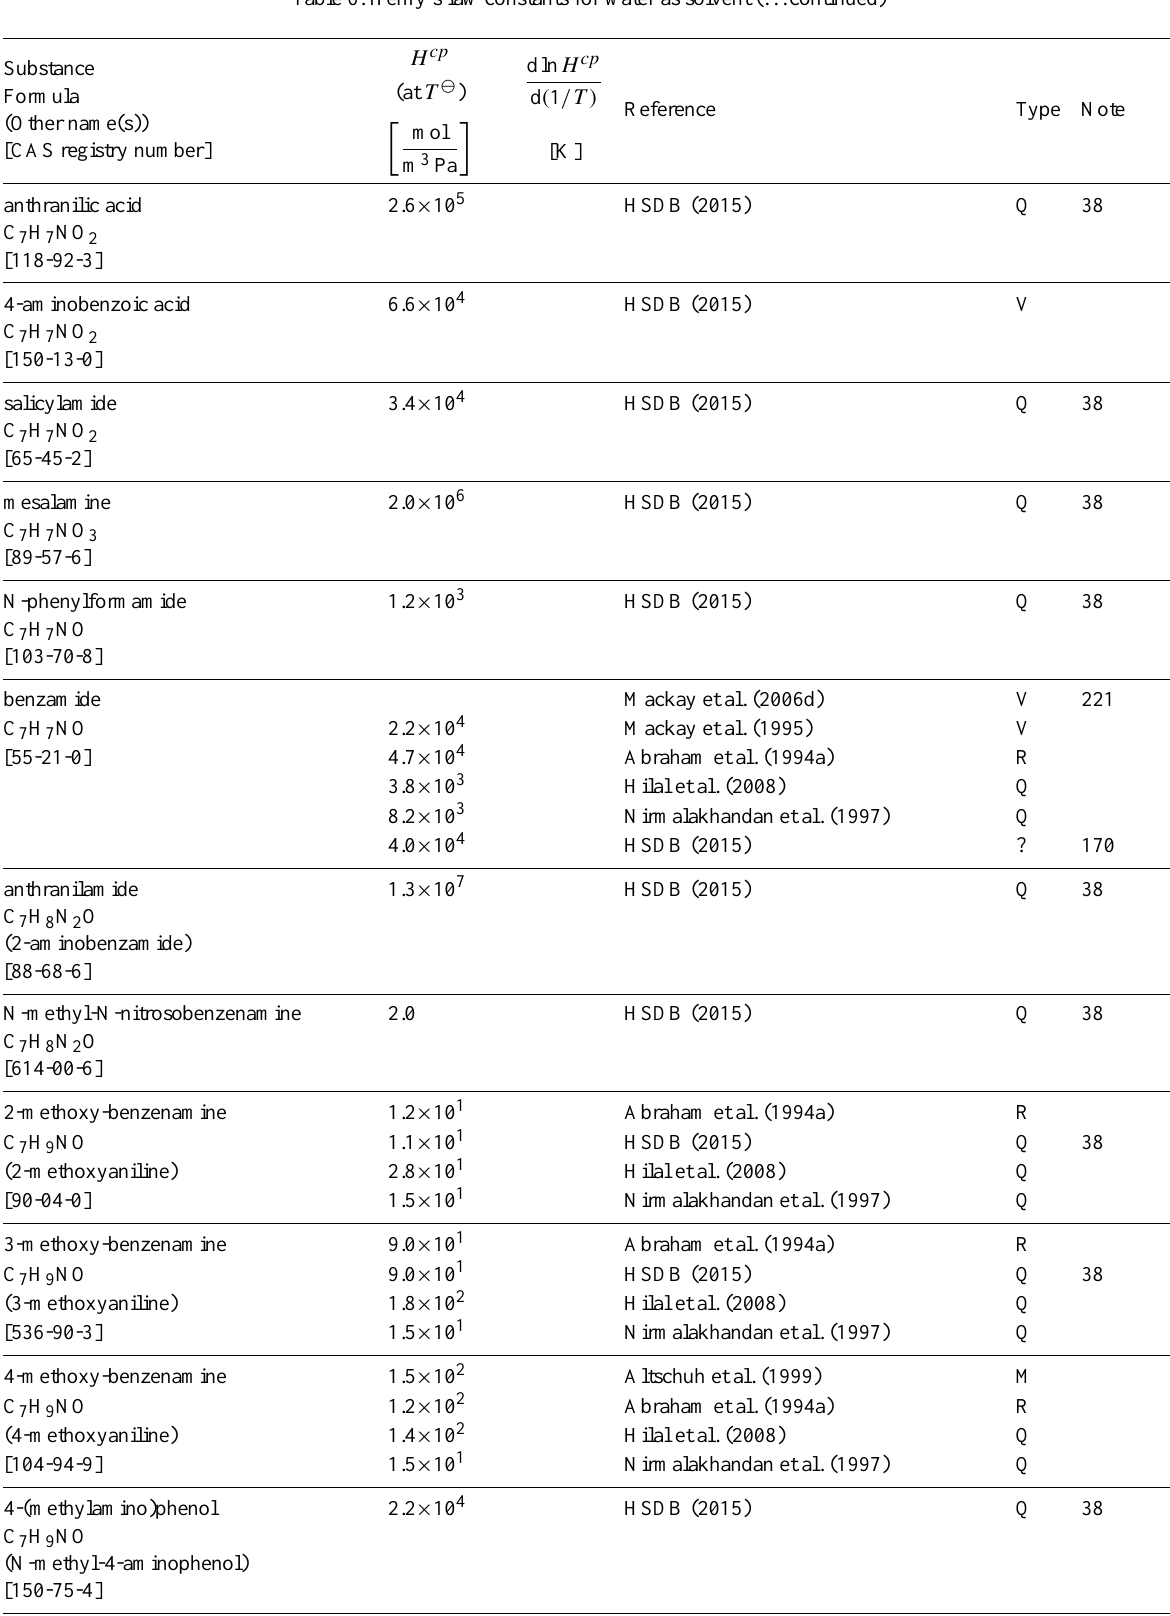
Table 6: Henry’s law constants for water as solvent